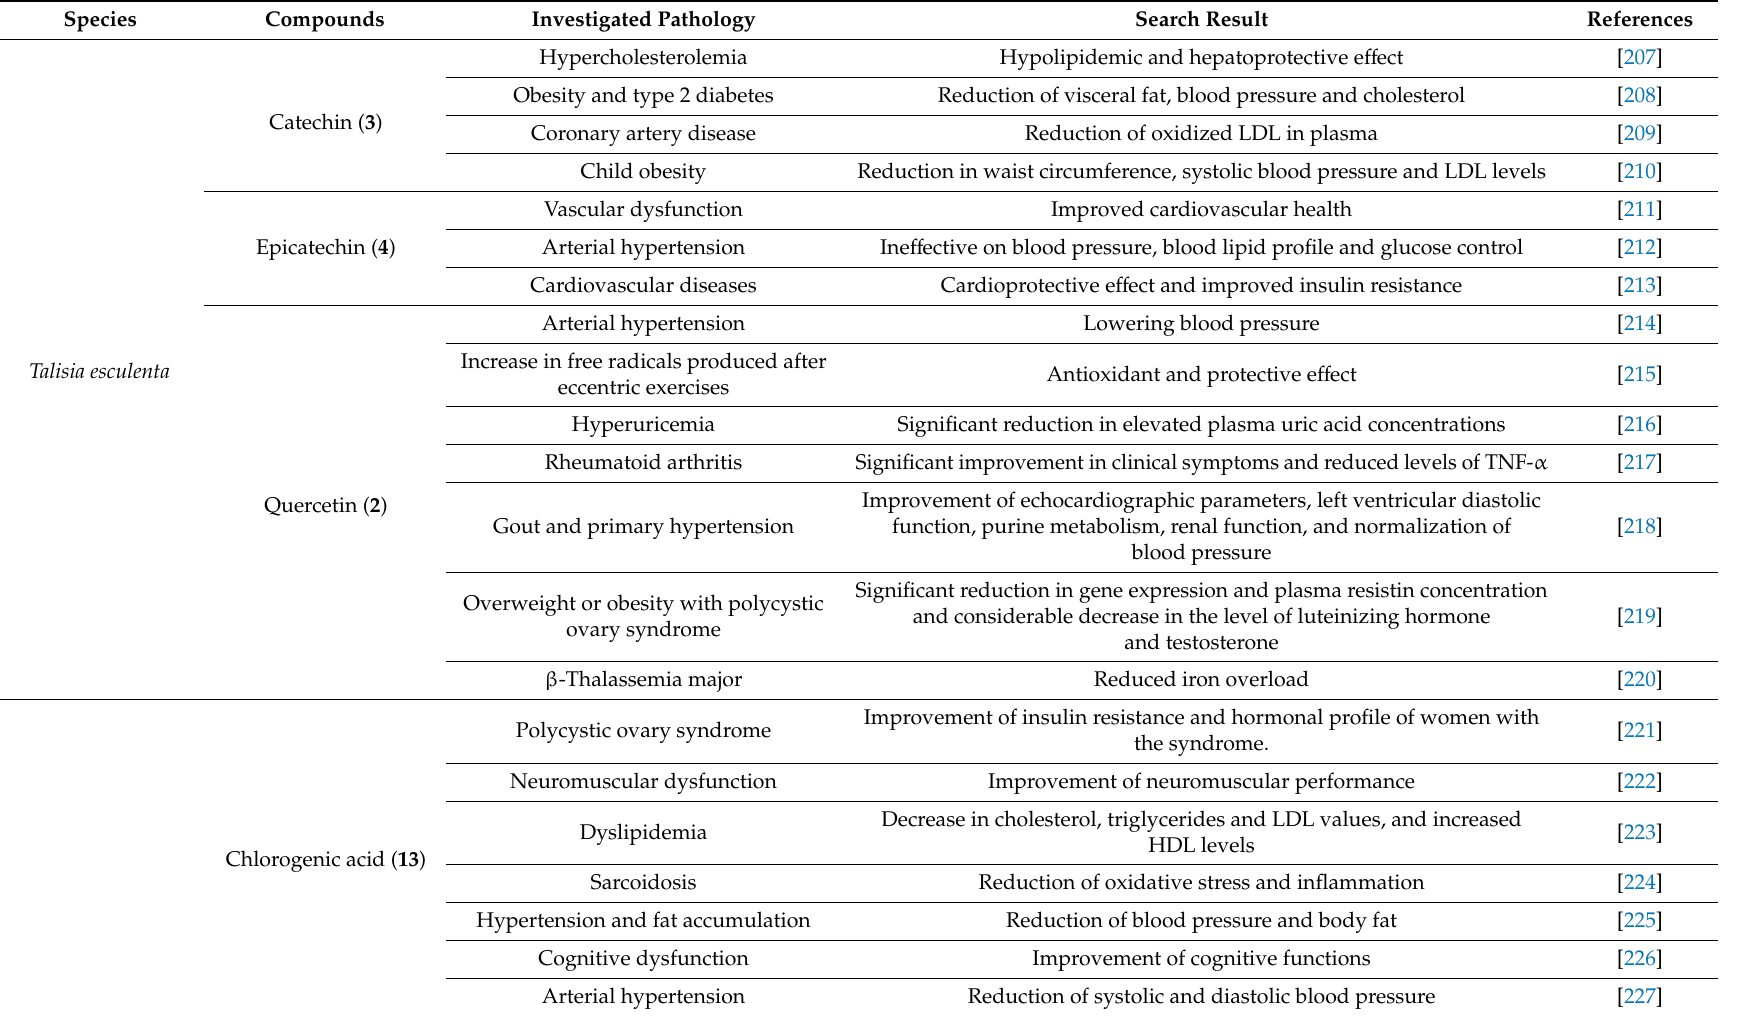
Table 5. Clinical trials with secondary metabolites of fruit plants belonging to the Brazilian